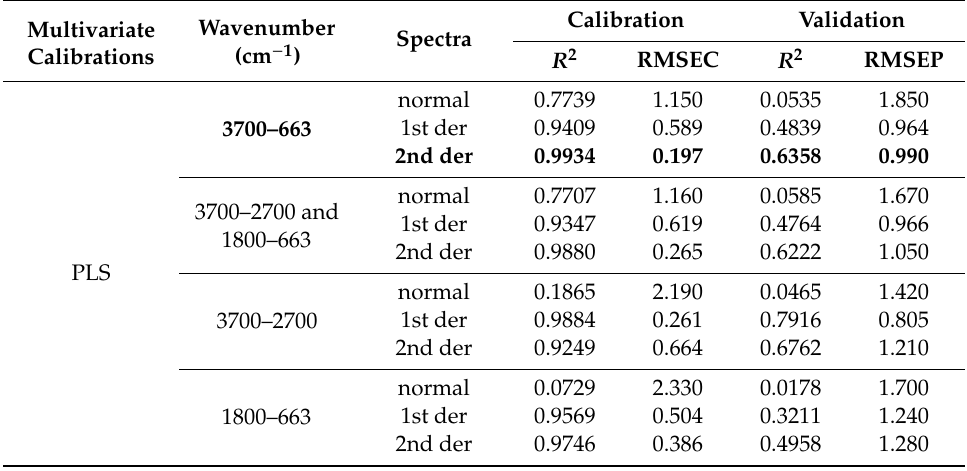
Table 5. The statistical parameters of multivariate calibrations of Principle Component Regression (PCR) and Partial Least Square (PLS) for a quantitative analysis of α -mangostin